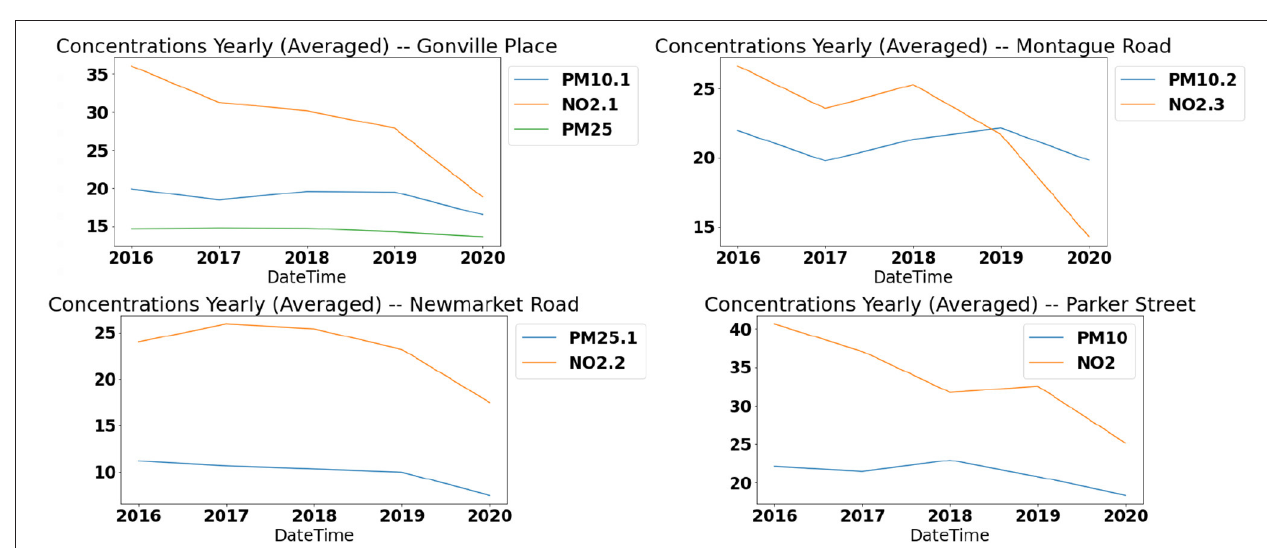
FIGURE 6 | Yearly trends: pollutant concentration trends in the recent